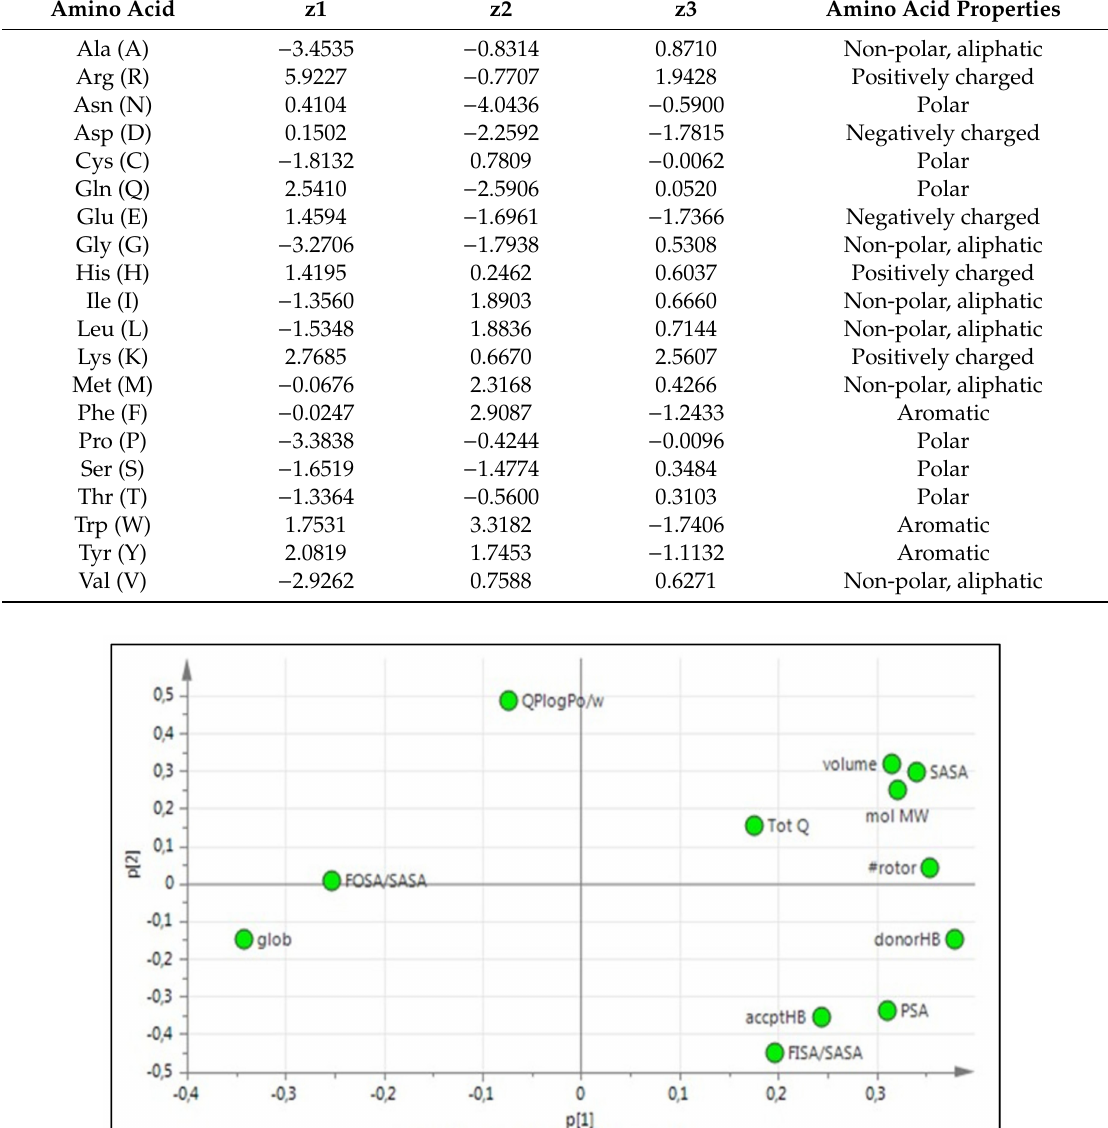
Table 1. Extracted z-scores for the 20 natural amino acids and their physicochemical properties.